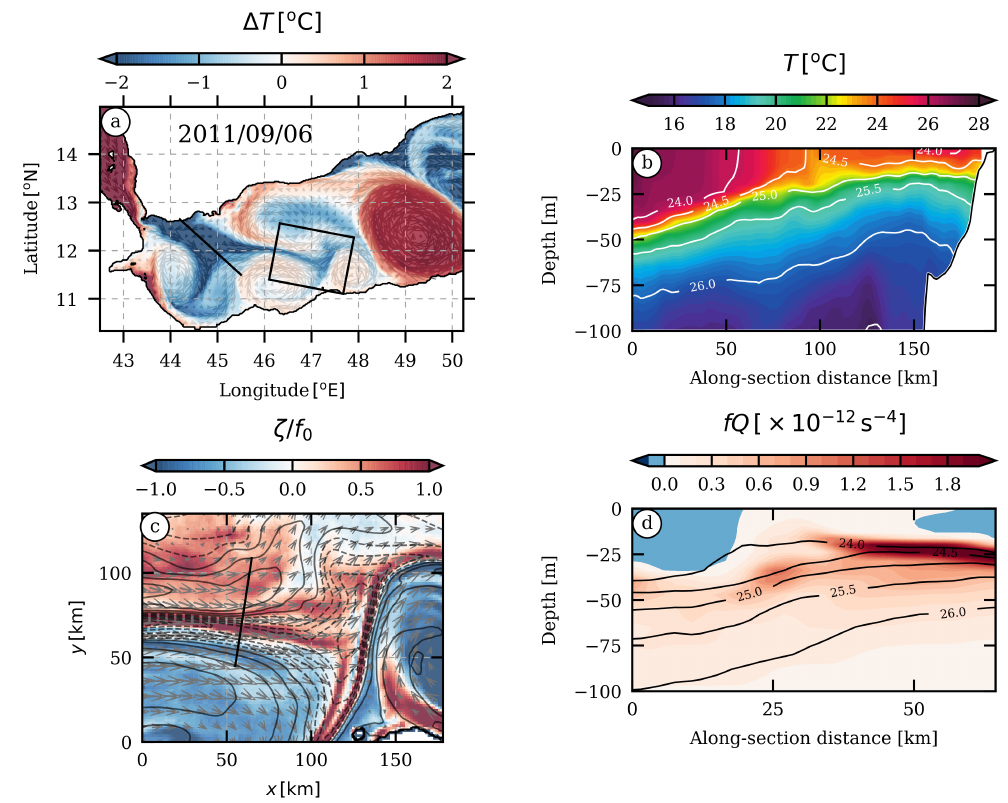
Figure 5. ( a ) Surface temperature anomaly in the Gulf of Aden. Arrows stand for the surface velocity vectors. ( b ) Vertical slice of temperature in the Gulf of Aden. The location of the section is drawn as a black solid line in ( a ). Density contours (kgm − 3 ) are drawn as white solid lines. ( c ) Surface relative vorticity normalized by the aeral average of the Coriolis frequency (see black square box in ( a ) for location). Black contours stand for the surface temperature anomaly. Arrows stand for the surface velocity vectors. ( d ) Vertical slice of PV.Density contours (kgm − 3 ) are drawn as black solid